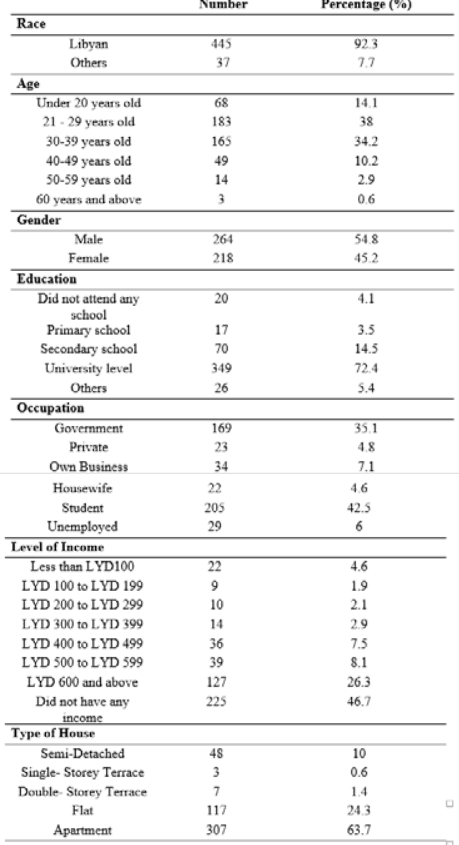
Table 2: Demographic background of the Respondents